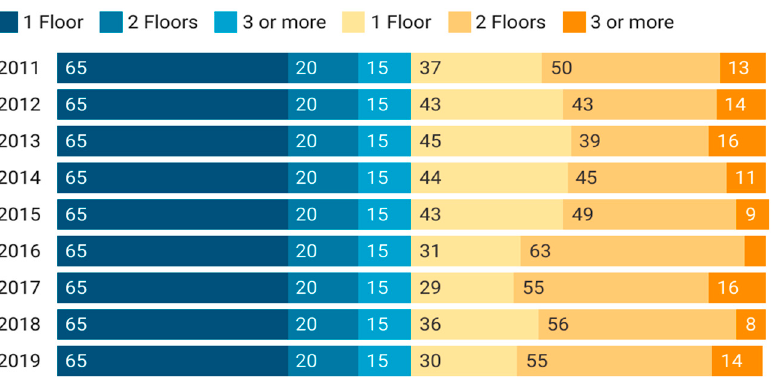
Figure 3. Percentage of residential buildings construction per year and per number of floors. Blue colors represent Bavaria province, and Murcia province in orange colors. Source: refs. [24,26].